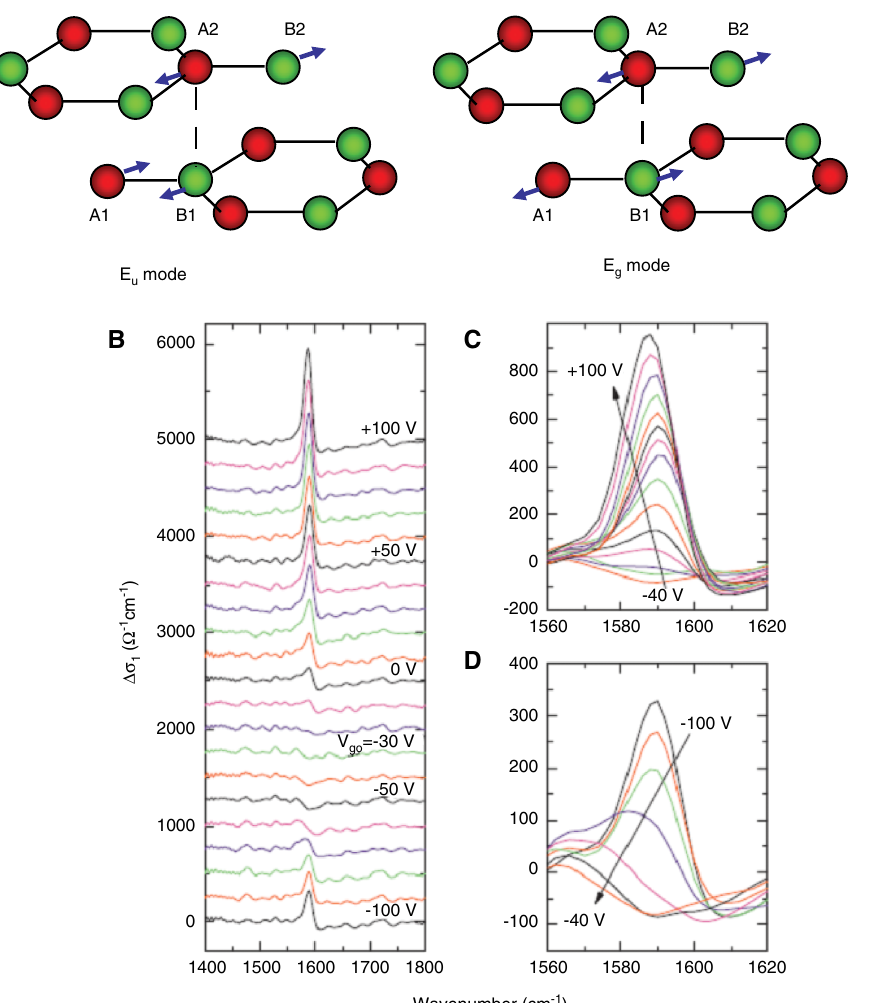
phonon and E phonon modes. (B) Extracted optical u g